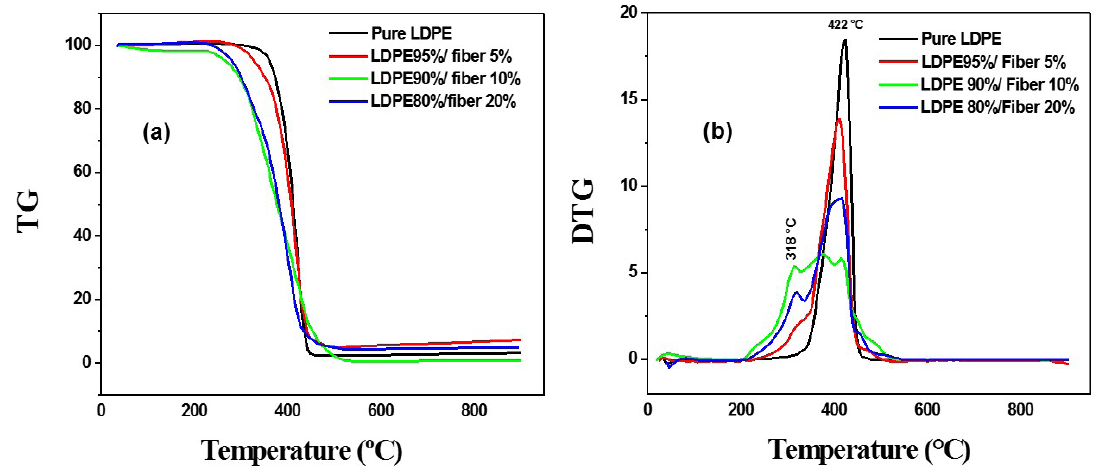
Figure 4. Thermal analysis of the pure matrix of LDPE and composites with babassu fiber (a) TG and (b) DTG.